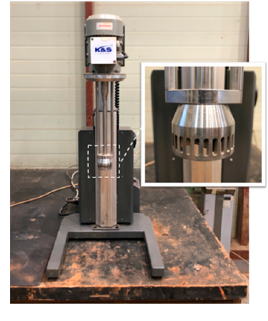
Figure 2. Homo mixer. Materials 2020 , 13 , x FOR PEER REVIEW